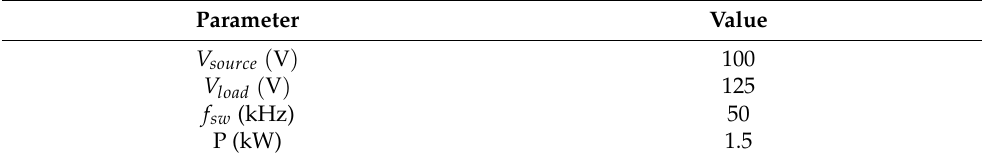
Table 1. Simulation conditions for the single-inductor topology case study.